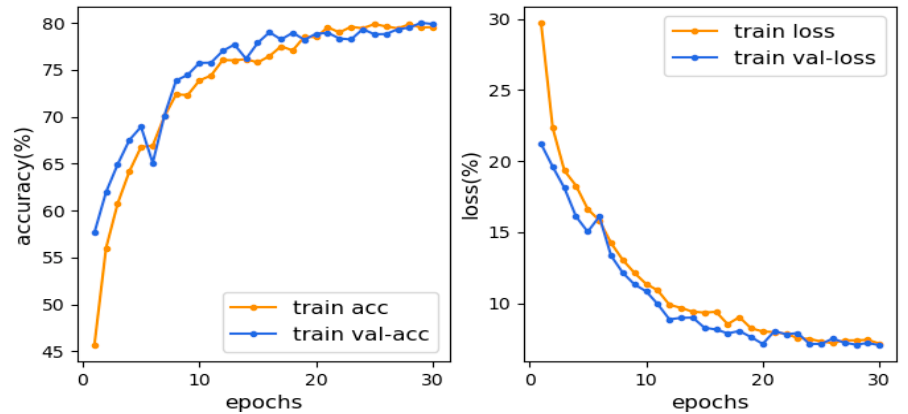
Figure 13. LSTM training results.